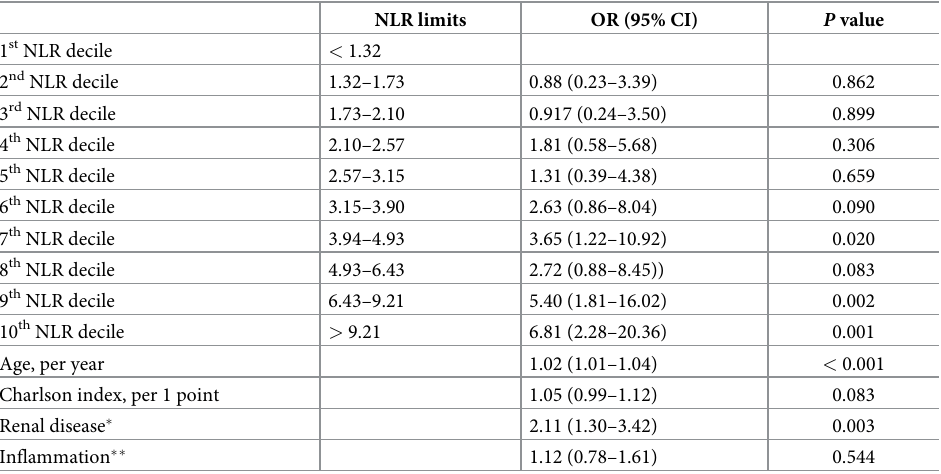
Table 3. Logistic regression model for prediction of ureteral catheterization by NLR (deciles) adjusted for age, Charlson’s comorbidity index, presence of renal disease and presence of inflammation. NLR limits OR (95% CI) P value